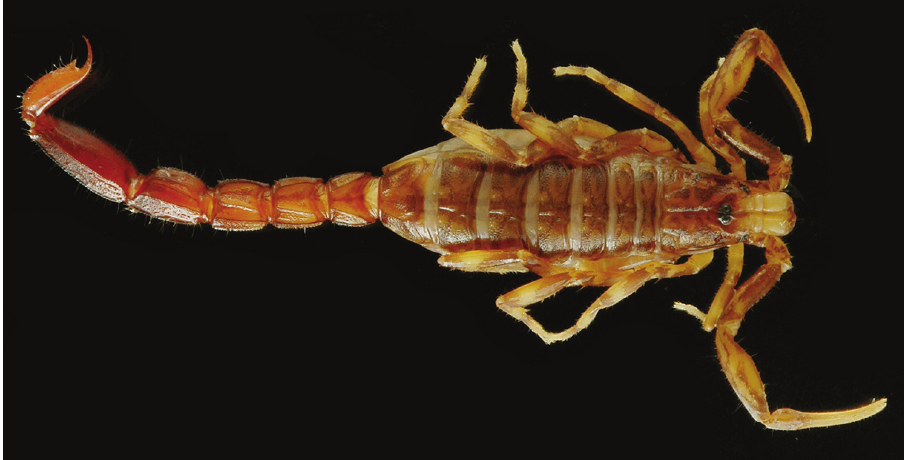
Figure 1. Ananteris coineaui , female holotype from Saut Pararé (photo MNHN / E.-A. Leguin). Arataye river, downstream from Saut Pararé, in a palm tree ( Astrocaryum paramaca ) in forest, two females (paratypes), J.P. Gasc coll., I/1981. Saül, in a palm tree, one female, deposited in the MNHN, W. Lourenço